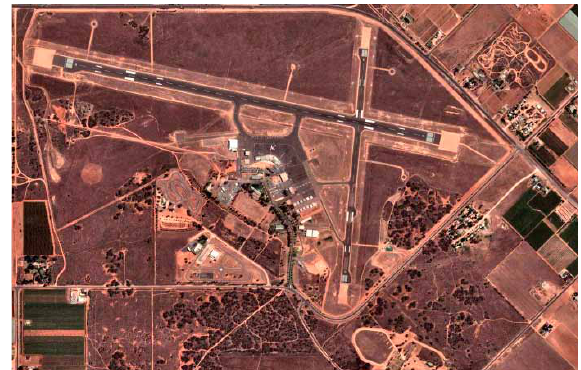
Fig. 2. Aerial view of Mildura Airport (Imagery ©2015 CNES/ Astrium, Cnes Spot Images, Digital